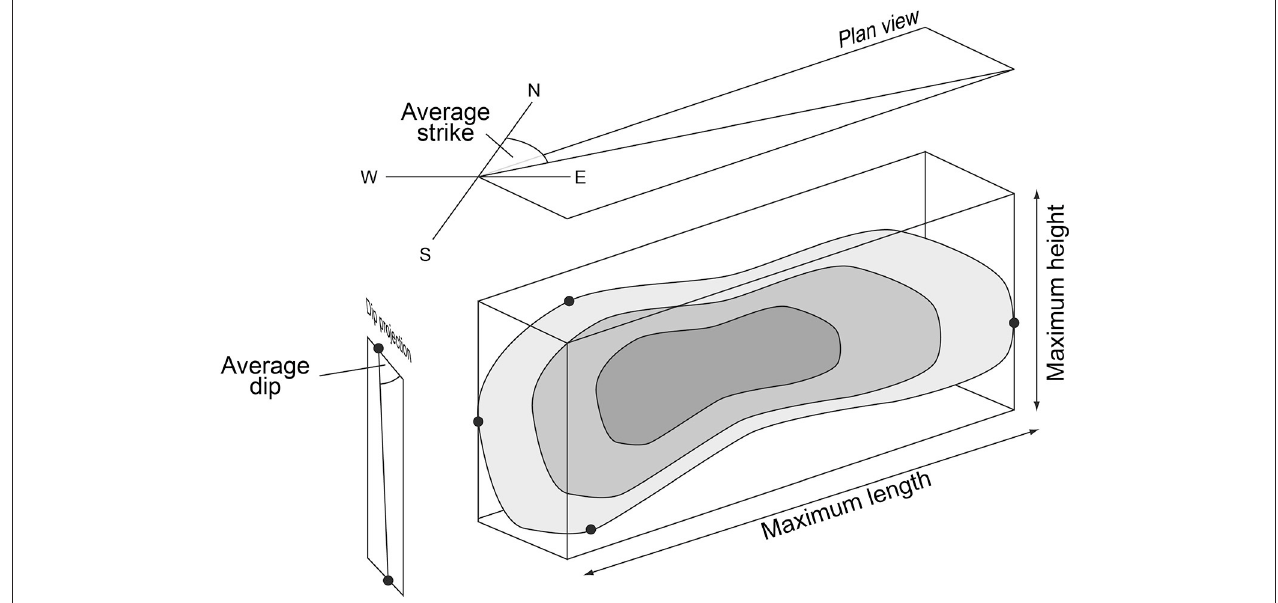
FIGURE 6 | 3-D diagram of displacement distribution on normal fault illustrating the key fault properties (average strike, -dip, maximum length and -height)